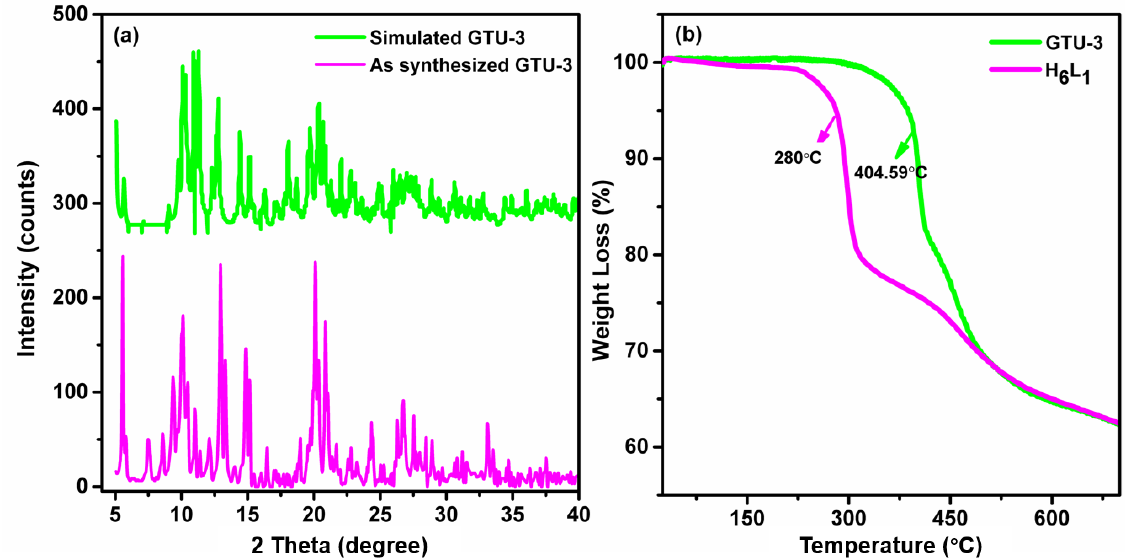
Figure 5. ( a ) Simulated and experimental PXRD patterns of GTU-3, ( b ) TGA thermogram of the synthesized GTU-3 and H 6 L 1 .